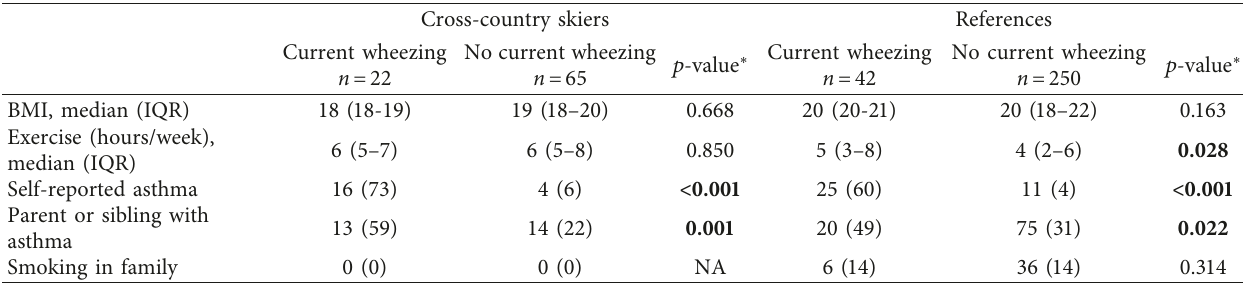
Table 3: Comparison between subjects with and without current wheezing among Swedish cross-country skiers in early adolescence and in a population-based reference